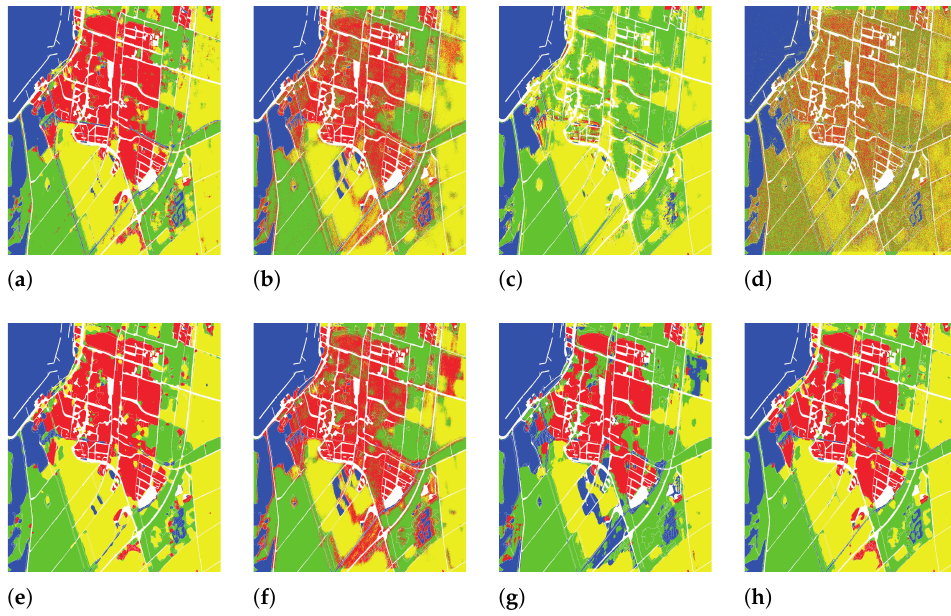
Figure 13. Classification results on Rs2-Flevoland. ( a ) DenseNet. ( b ) RF. ( c ) KNN. ( d ) DT. ( e ) Co-